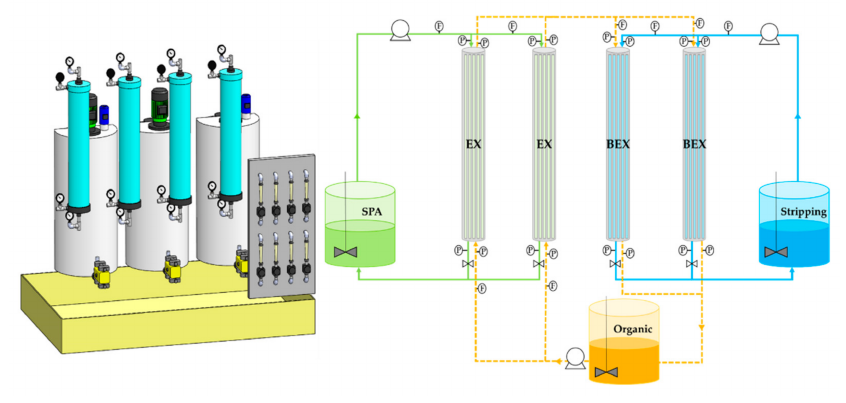
Figure 1. Non-dispersive solvent extraction (NDSX) pilot plant. Table 4. Characteristics of the hollow fiber membrane